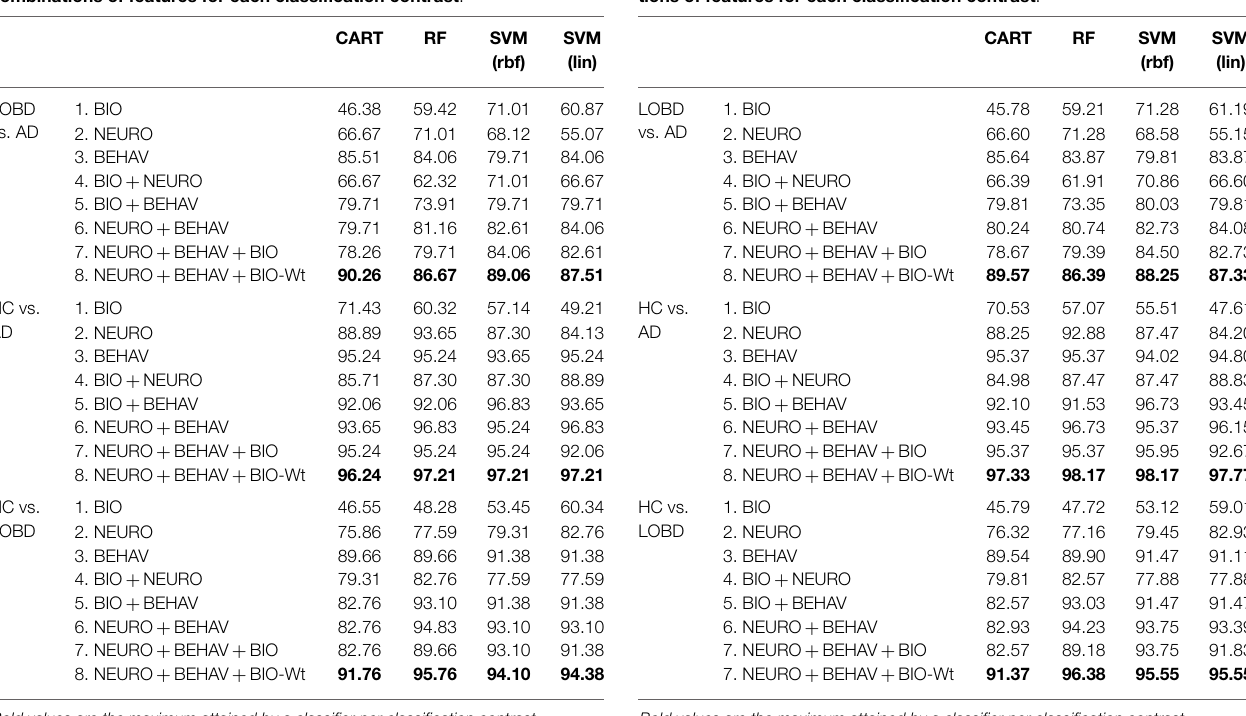
TABLE 3 | LOO accuracy estimation of the classifiers on the various combinations of features for each classification contrast .